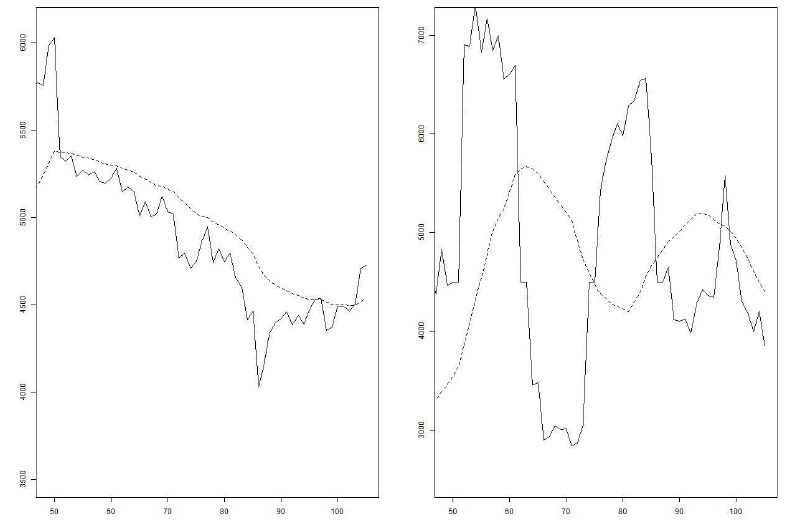
Fig. 4 – Forecasting malting barley and potatoes on the technical indicator base. Source: own